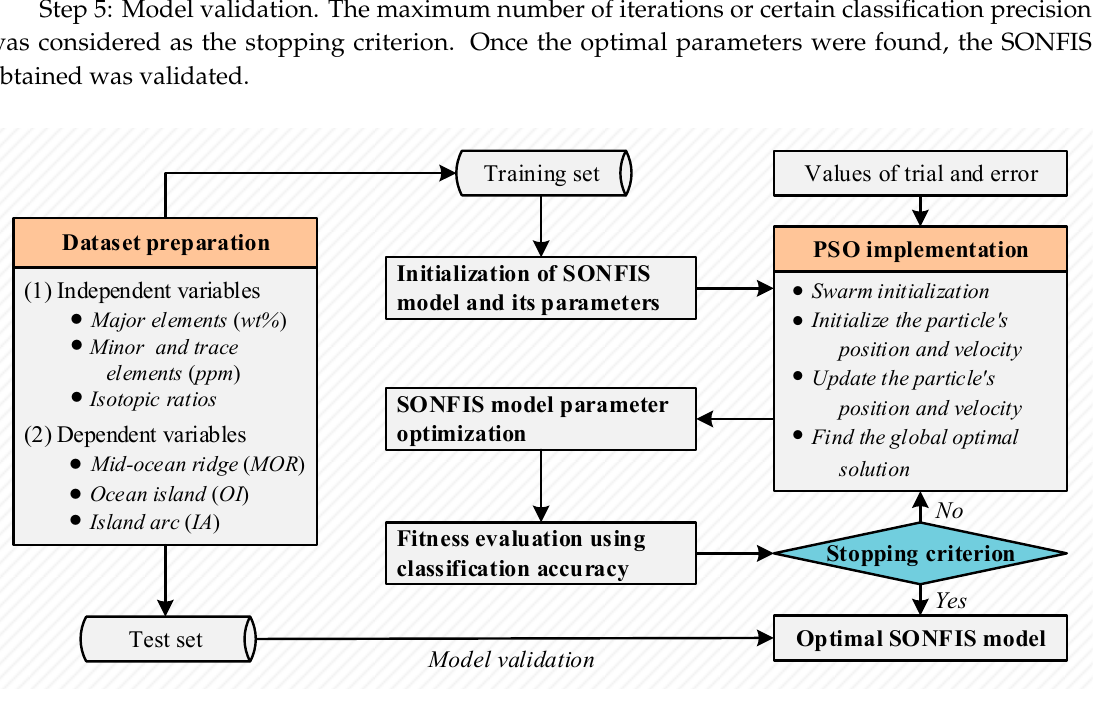
Figure 3. Architecture description of the proposed hybrid swarm optimized neural fuzzy inference system ( SONFIS) method for tectonic discrimination of basalts.